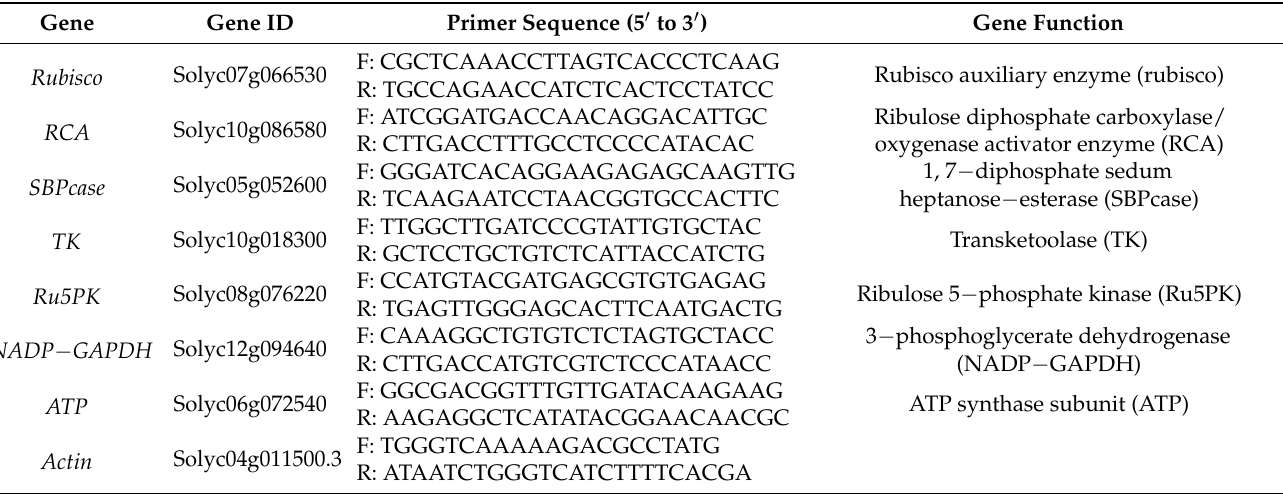
Table 4. Primer sequences for real − time fluorescent quantitative